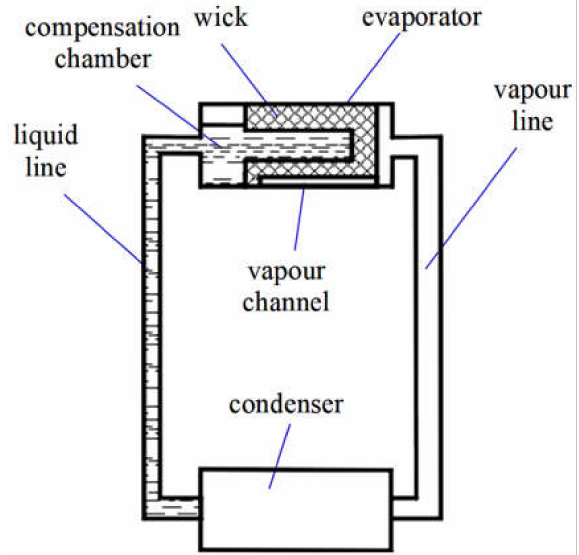
Figure 1. The layout of LHP [20].